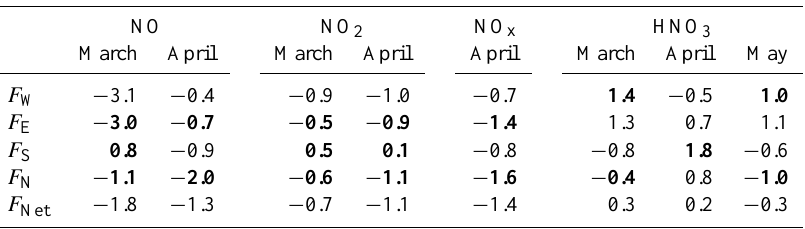
Fig. 11. The time series of the simulated pollutants concentration over Cape Town in 2001–2004. The extreme values (99 percentiles) are indicated with red dashed. Table 2. The low-level flux budget of pollutants (NO, NO 2 , NO x and HNO 3 ) during extreme events over Cape Town, showing the inward and outward fluxes at the western ( F W ), eastern ( F E ), southern ( F S ) and northern ( F N ) boundaries of Cape Town and the net flux ( F Net ) over the city. A positive zonal flux ( F E or F W ) implies a westerly flux (i.e. a flux from a westerly direction), while a negative zonal flux means the opposite. A positive meridional flux ( F N or F S ) denotes a southerly flux (i.e. a flux from a southerly direction), while a negative zonal flux means the opposite. Inward fluxes (from any boundary or direction) into the city are in bold font, while outward fluxes from the city are in thin font. A positive F Net indicates divergence (i.e. depletion) of the pollutants over the city, while a negative net flux means convergence (i.e. accumulation) of the pollutants over the